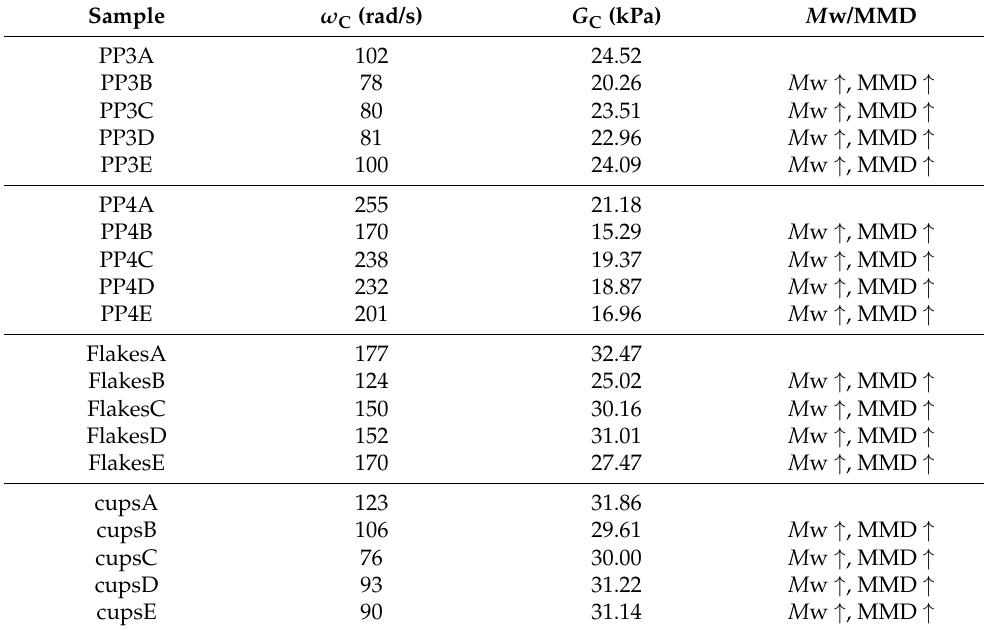
Table 1. Results of crossover point (G (cid:48) = G”) from dynamic rheological measurements at 230 ◦